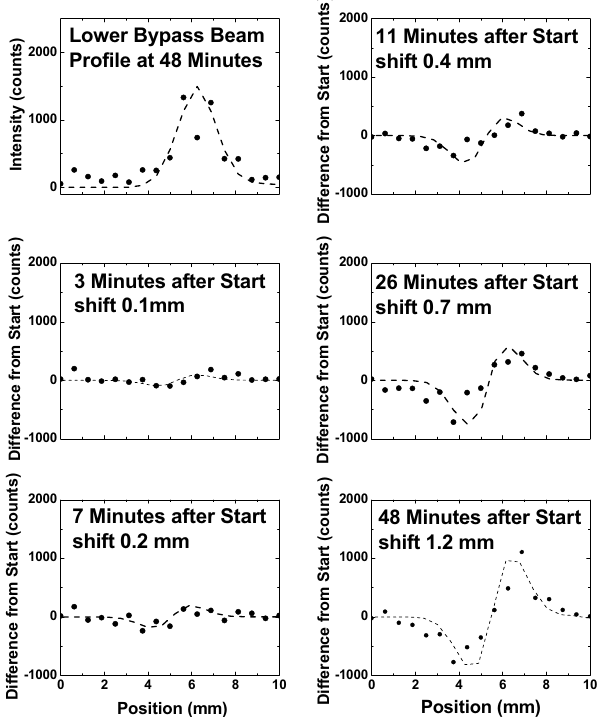
Figure 7. Left, top: measured, the solid dots, and fitted, the dashed line, horizontal profiles of the lower bypass beam. These were used as reference values. Other figures show differences between profiles measured and fitted at various times after beam injection with the reference values. The listed shift values are differences in the fitted peak positions used in each case. See text for details.